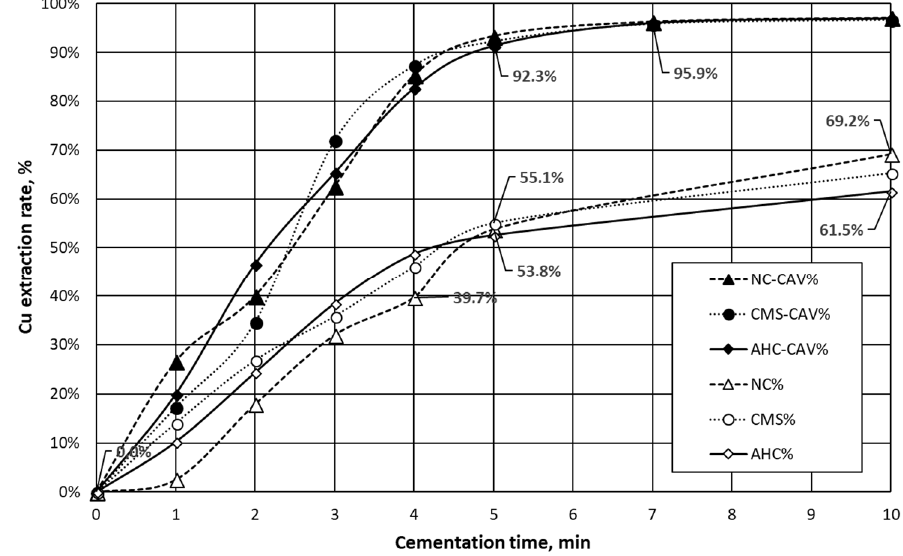
Figure 5. Dependence of the copper extraction rate, depending on the treatment time and setup used.